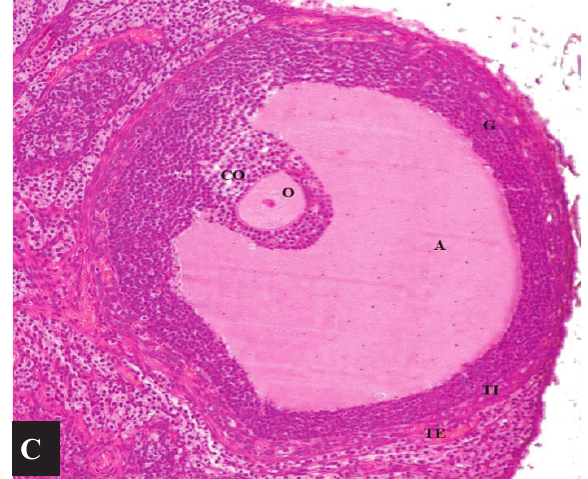
Fig-4C: Graafian follicle of rat experimental group C showing normal structure, Antrum (A), Ovum (O), Zona Granulosa (G), Theca Interna (TI), Theca Externa (TE).(H & E at 20x)